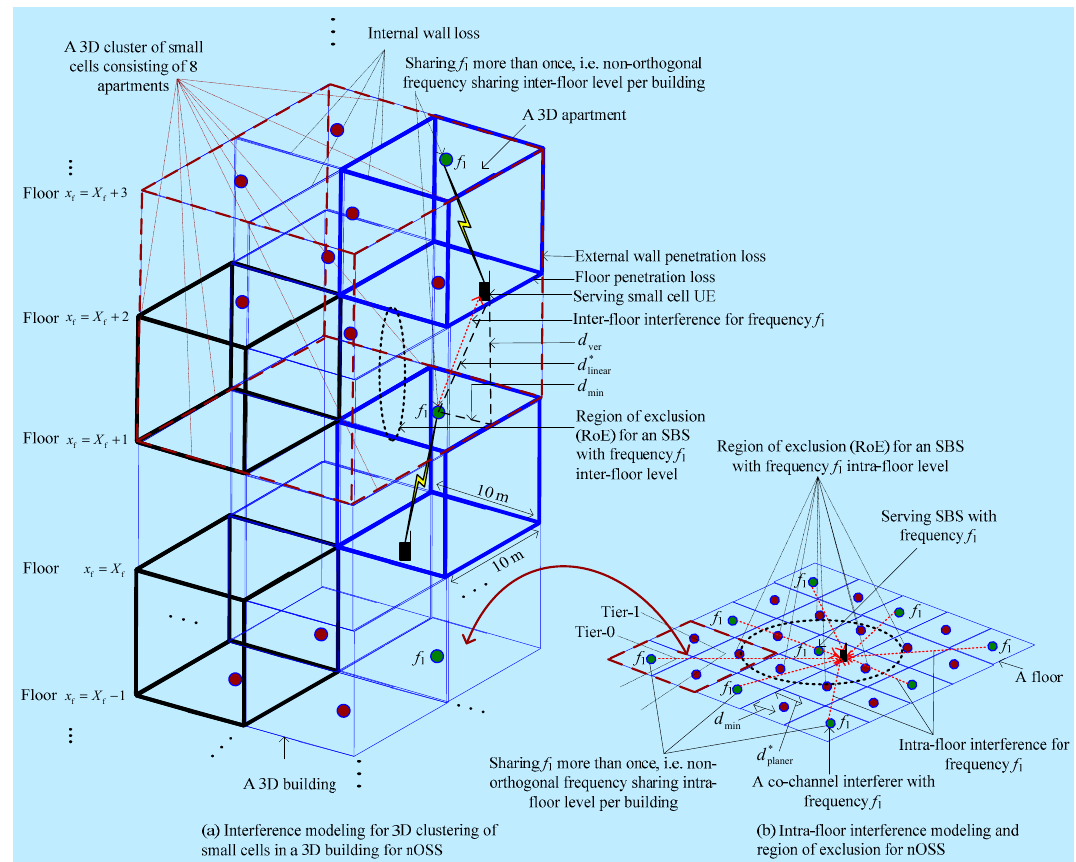
Figure B1. nOSS with small cells in a building for 3D clustering of SBSs: ( a ) 3D clustering within a building, ( b ) Intra-floor interference modeling.